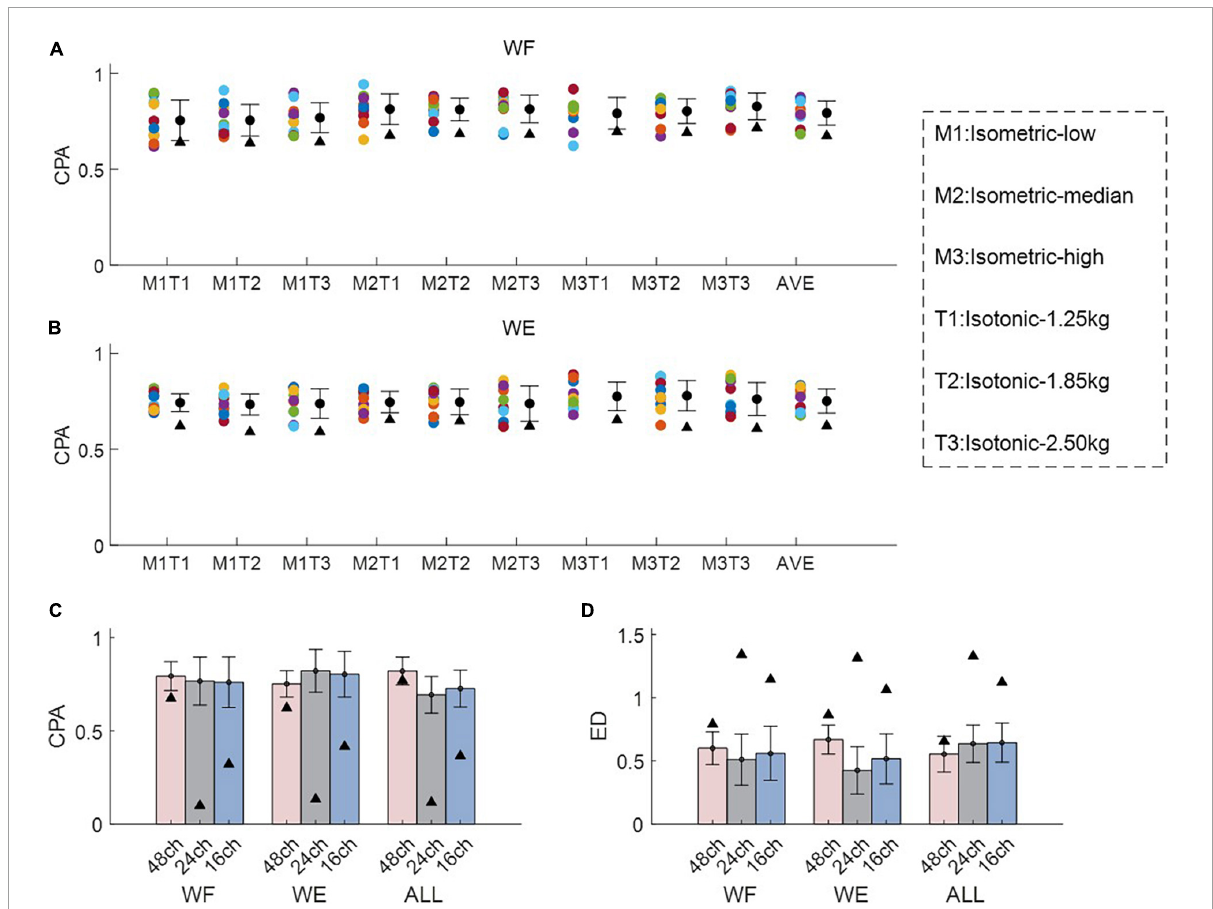
FIGURE5 Inter-mode similarity of muscle synergies for wrist movements. (A,B) Demonstrate the inter-mode CPA for all force-weight combinations for WF and WE, where M1-M3 denote different force levels under isometric mode, and T1-T3 denote different weights under isotonic mode. Herein circles with different colors are corresponding to different subjects, the black triangles denote CPA thresholds and ED thresholds under each condition. In (C,D) , both CPA and ED were used as the similarity metrics, and three different electrode configurations denoted as 48ch, 24ch, and 16ch were considered, respectively in (A,B) .